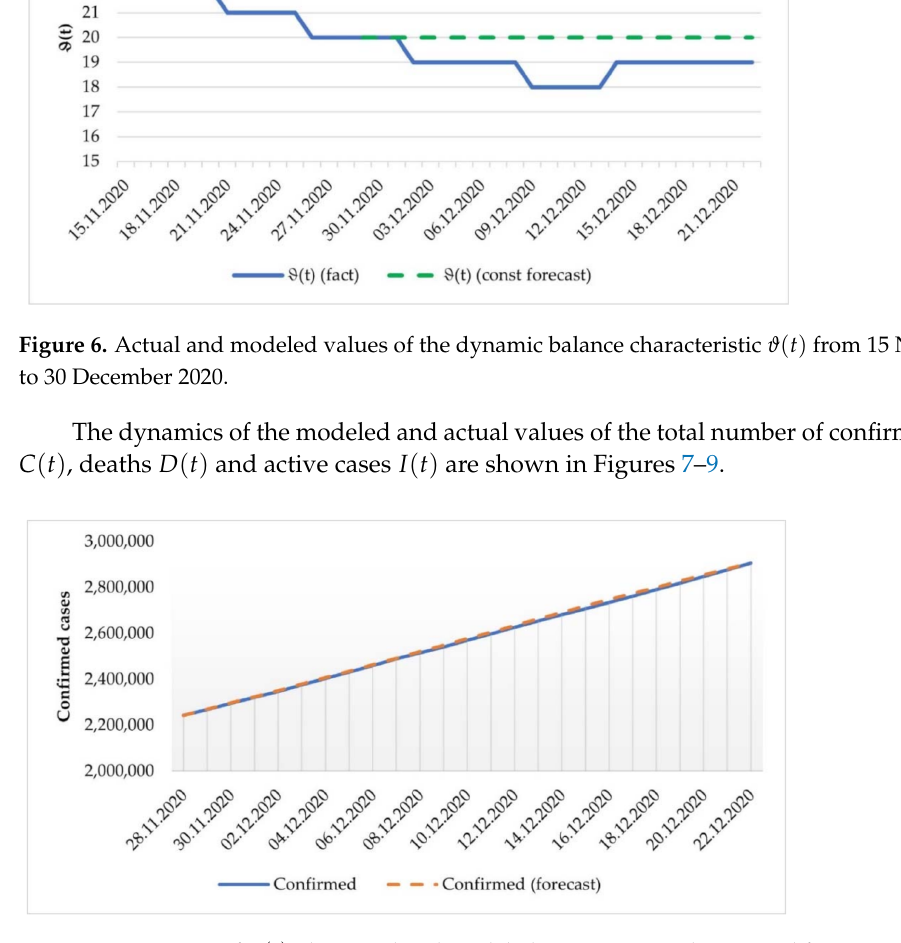
Figure 7. Dynamics of C ( t ) , the actual and modeled trajectories in the interval from 1 December